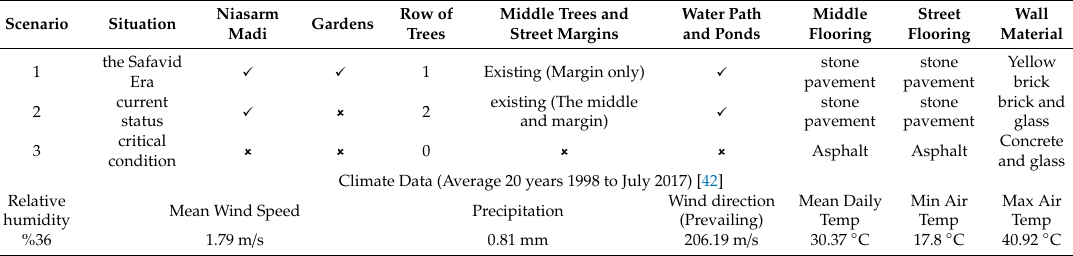
Table 2. Description of three scenarios of Chahar Bagh Street and climatic components.